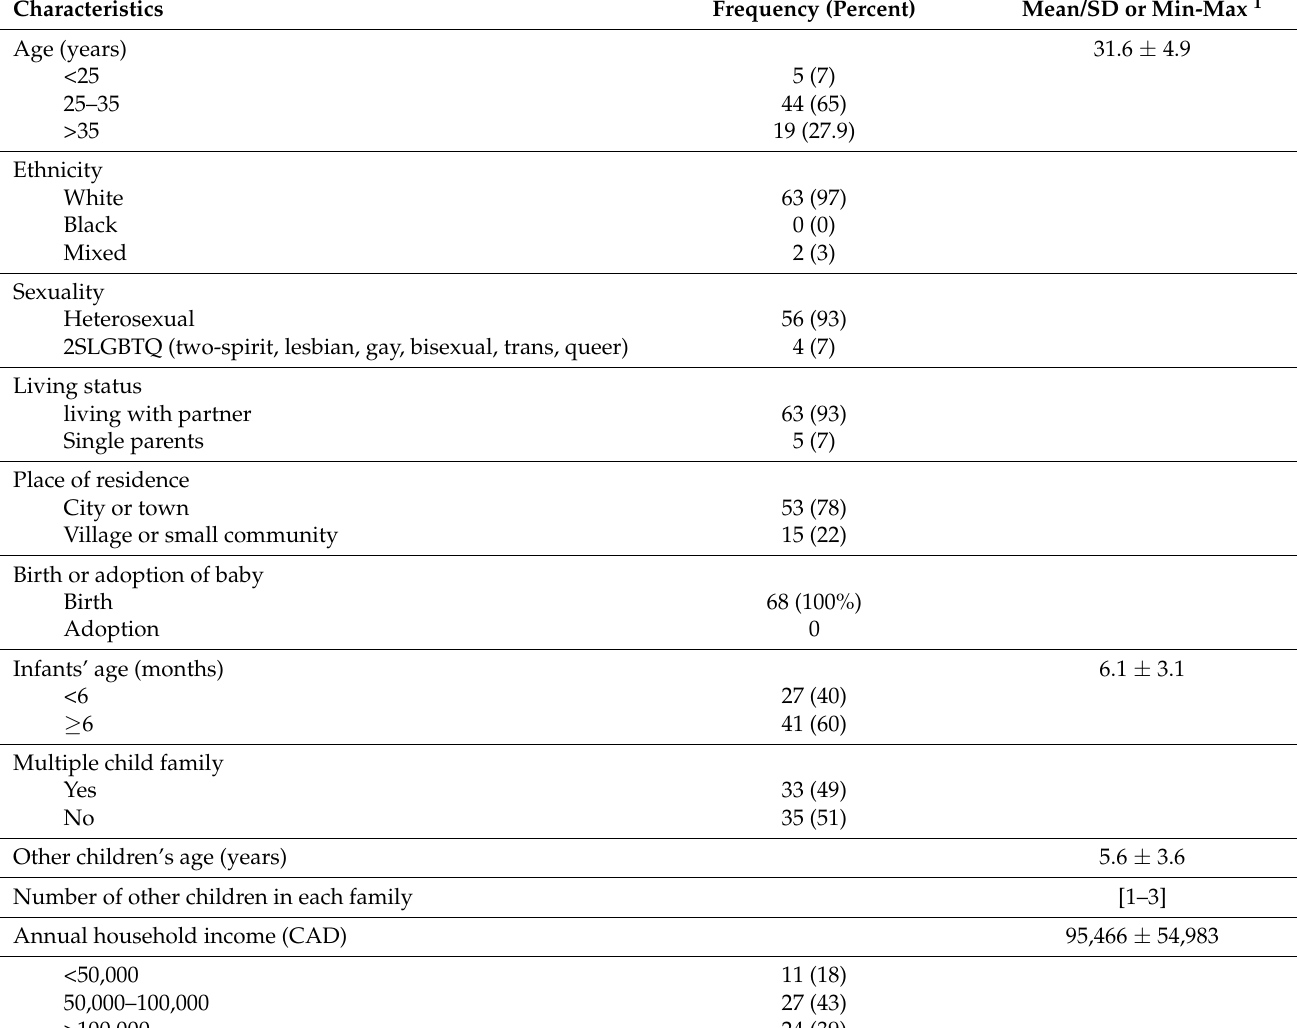
Table 1. Characteristics of study participants ( n =